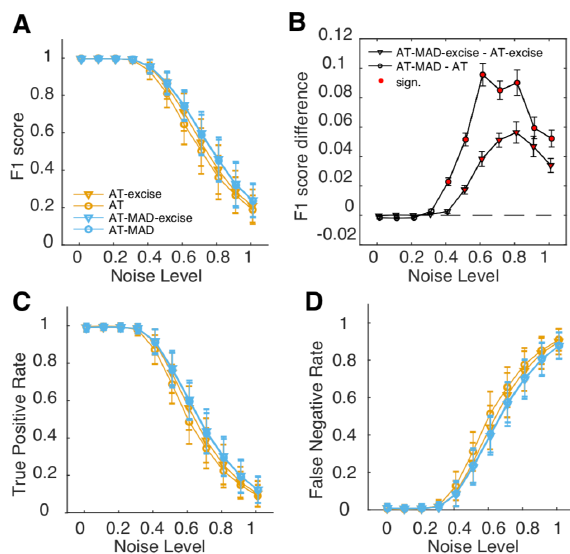
Figure 2. Robust estimation of threshold parameters results in improved detection performance (A) Mean and standard error of F1 score as a function of noise for two versions of the original algorithm (orange, AT and AT-excise) and two versions using the robust estimator (blue, AT- MAD and AT-MAD-excise). Versions using MAD consistently outperform (compare orange vs blue). Using the original data, excising some data improves detection performance (compare triangles and circles, orange lines), whereas it makes no difference for versions using the MAD estimator (triangles and circles, blue lines). (B) Mean and standard error of the pairwise difference in F1 score comparing AT vs AT-MAD (triangles), and AT-excise and AT-MAD-excise (circles). Filled, red circles represent statistically different score (p<0.05, multiple comparison corrected). Threshold estimation using MAD shows significantly improved performance for noise levels at 0.4 and above, particularly for the algorithm as originally proposed (triangles). (C-D) Mean and standard deviation of the true positive rate (C), and false negative rate (D) for the four different versions of the algorithm. Improvements in (A-B) can be traced both to a higher true positive rate (C) and a lower false negative rate (D).